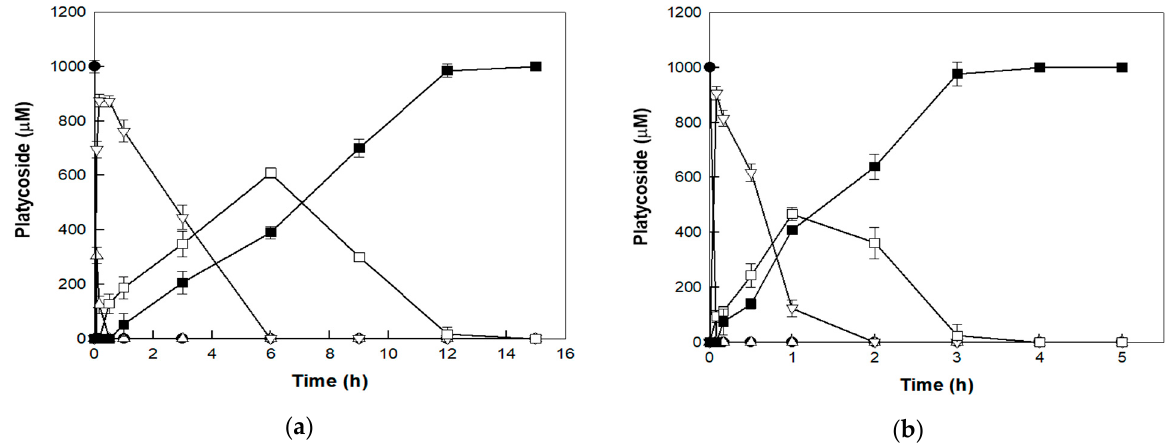
Figure 5. Biotransformation of platycoside E (closed circle) into despiose-xylosylated platycodin D (closed square) via platycodin D 3 (open triangle), platycodin D (open inverted triangle), and deapiosylated platycodin D (open square) by cytolase PCL5 at ( a ) atmospheric pressure and ( b ) high hydrostatic pressure. Data represent the means of three experiments ± standard deviation.